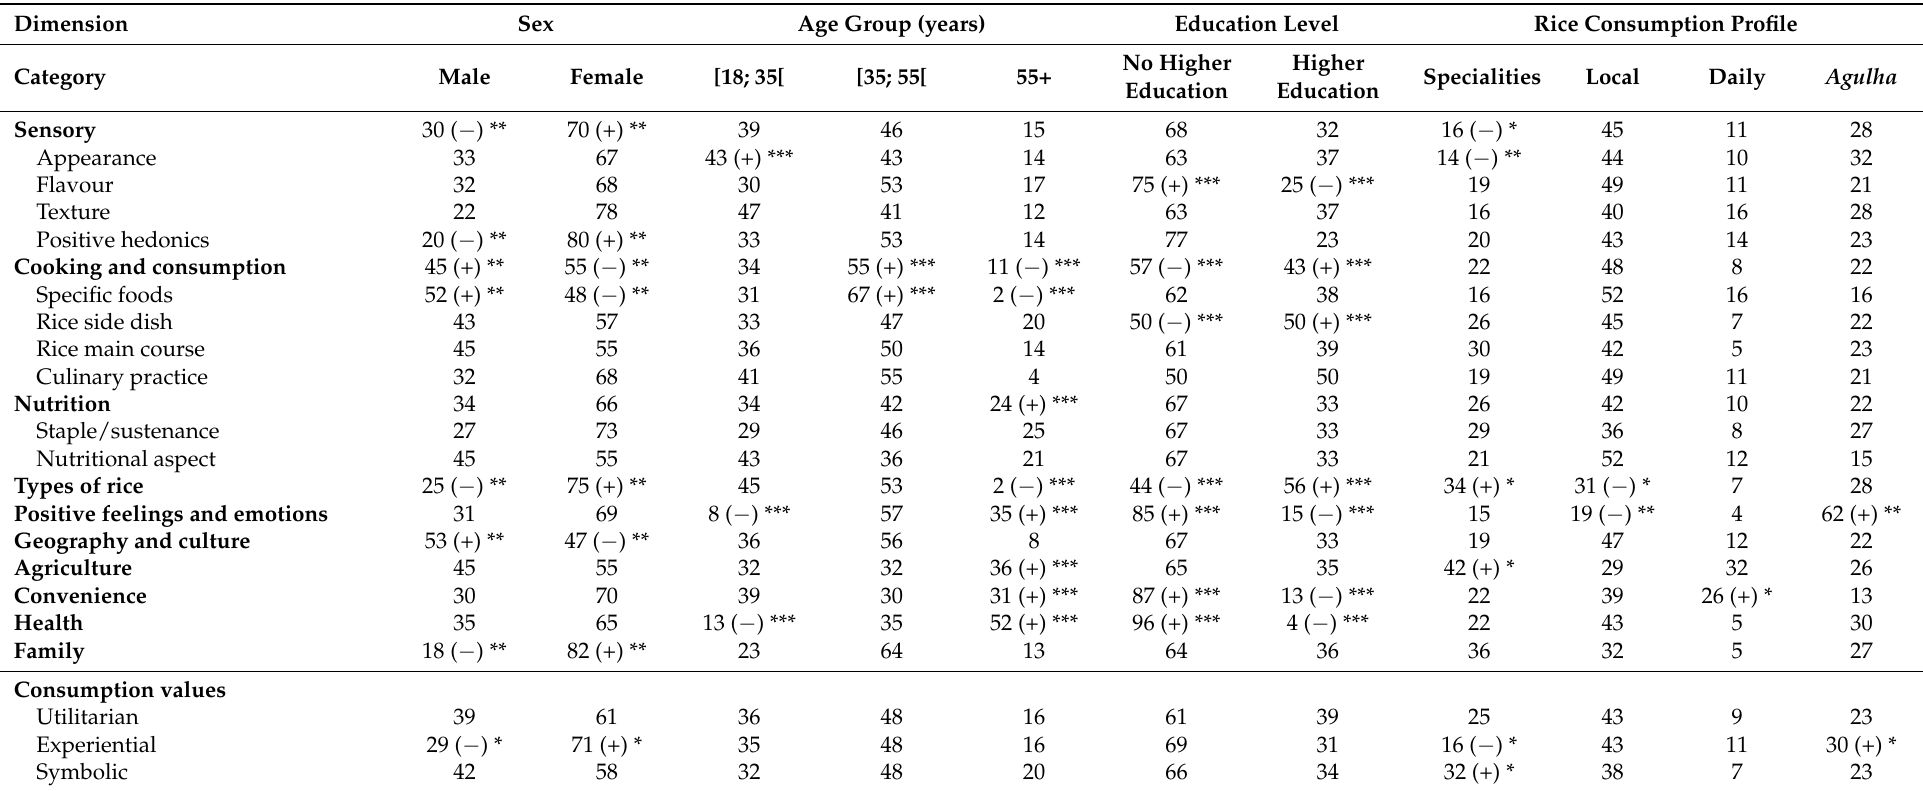
Table 6. Frequency (%) of elicited words according to dimensions, categories, and values in the free word association task using the “rice” stimulus according to sex, age group, education level, and rice consumption